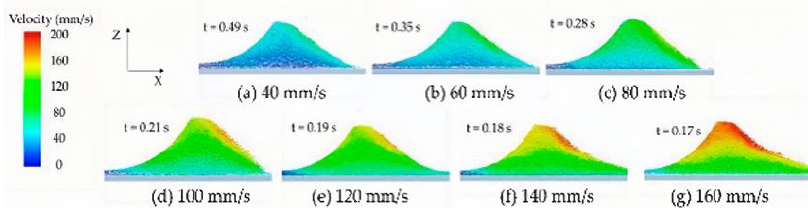
Figure 8. The powder-bed characteristics under different layer thickness values: ( a ) H = 50 μm; ( b )H = 75 μm; and ( c ) H = 1 50 μm [ 46]. In order to improve the forming precision and efficiency of the 3DP process, Deng et al. [47] used the volume-of-fluid (VOF) method to simulate the impact and infiltration processes on the powder bed with the single micrometer droplet. The simulated results showed that the binder droplet had a longer penetration time, a wider spreading diame- ter, and a smaller penetration depth on the smaller particle size (Figure 9). The comparison with the experimental results proved the feasibility of the simulation in the binder impact process and infiltration process on the powder bed.